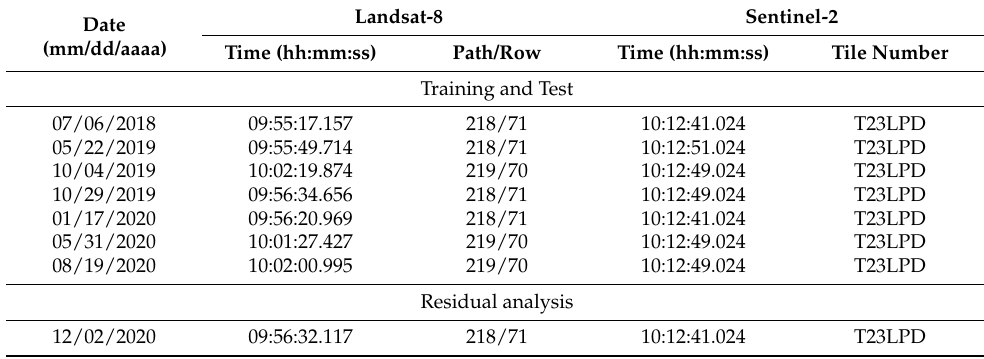
Table 3. Characteristics of the eight images selected to develop the